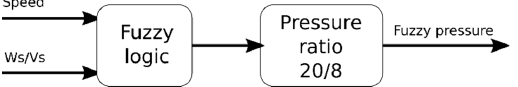
Figure 7. Block scheme of the fuzzy controller.